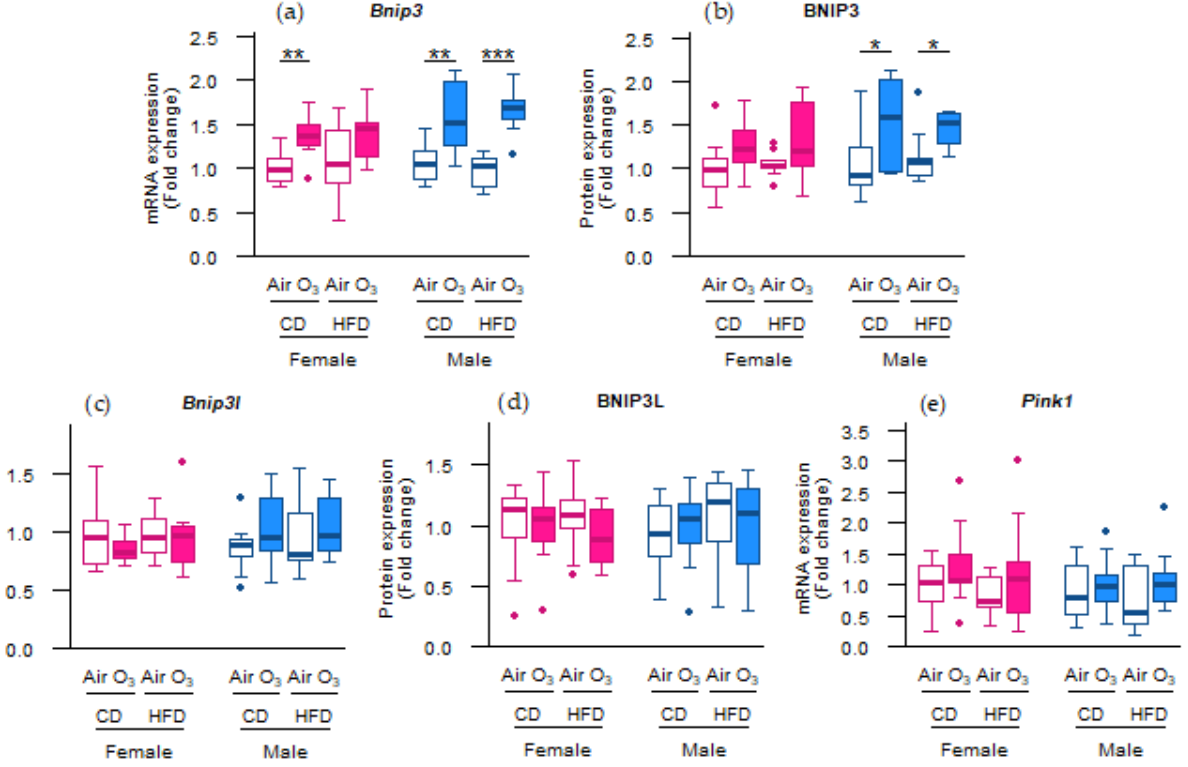
Figure 3. Acute ozone exposure altered the molecular control of receptor-mediated mitophagy rather than ubiquitin- mediated mitophagy. Receptor-mediated mitophagy: ( a ) Bnip3 mRNA expression, ( b ) BNIP3 protein expression, ( c ) Bnip3l mRNA expression, ( d ) and BNIP3L protein expression. Ubiquitin-mediated mitophagy: ( e ) Pink1 mRNA expres- sion. All of the markers were assessed within two hours after exposure to filtered air or ozone in lungs of female and male offspring from dams fed a perinatal control diet (CD) or high-fat diet (HFD). Data are presented as boxplots. Statistical analysis by two-way ANOVA with a Holm–Sidak post-hoc test. n = 9–10 per group ( a , c , e ) or n = 7–10 per group ( b , d ). * p < 0.05, ** p < 0.01, *** p < 0.001. O 3